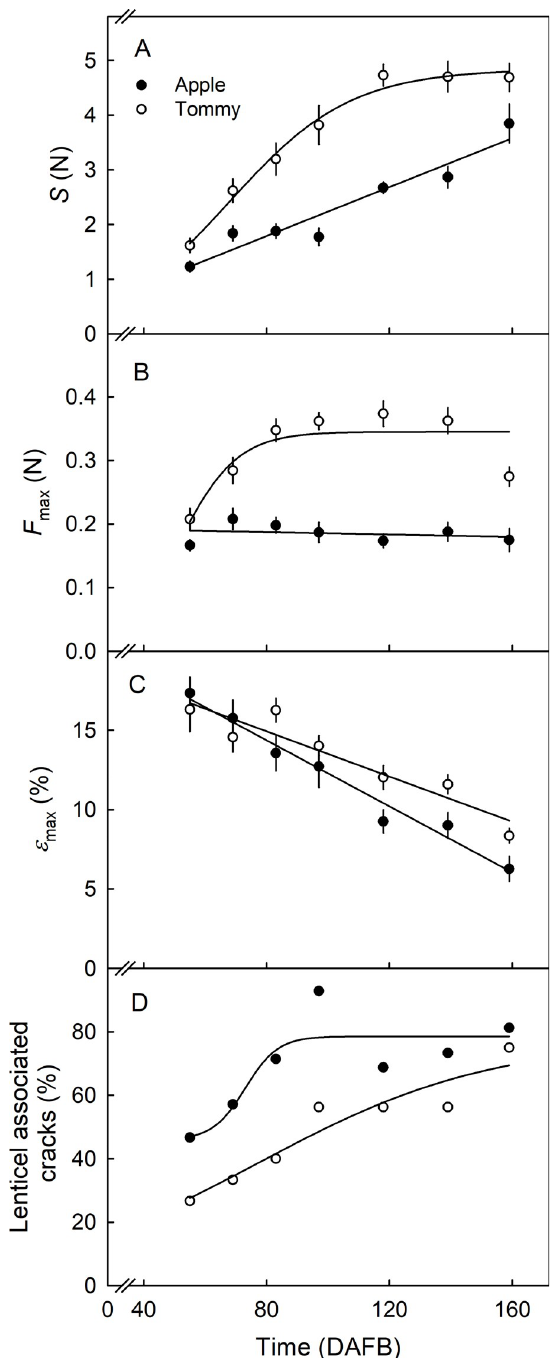
Fig 10. Developmental time course of change in stiffness (S) (A), maximum force ( F max ) (B) and strain at maximum force ( ε max ) (C) of the cuticular membrane (CM) of developing ’Apple’ and ’Tommy Atkins’ mango. (D) Frequency of occasions where failure was associated with lenticels. The x-axis scale is in days after full bloom (DAFB). Data in Fig 10A-10C represent means ± SE. The number of replicates was